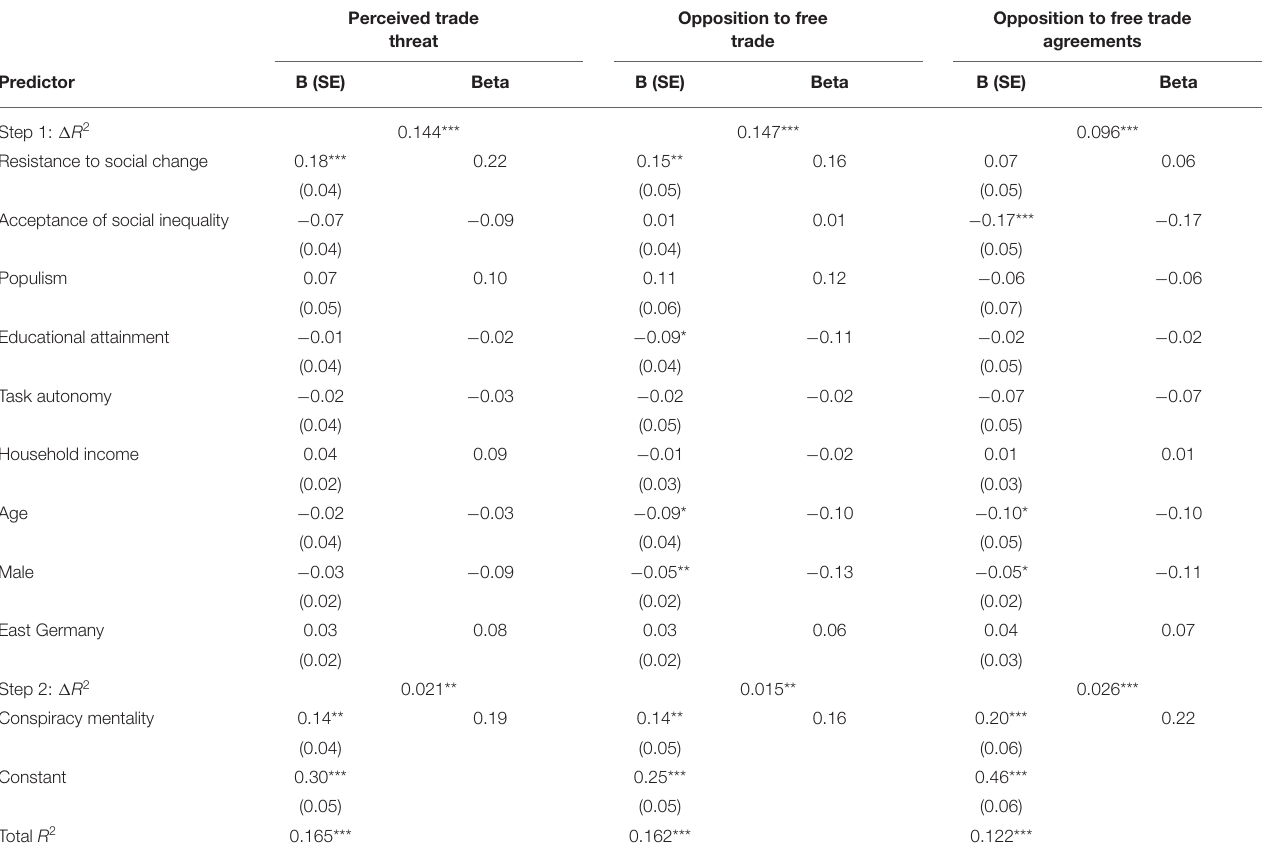
TABLE 3 | Hierarchical regression predicting anti-trade perceptions and attitudes.